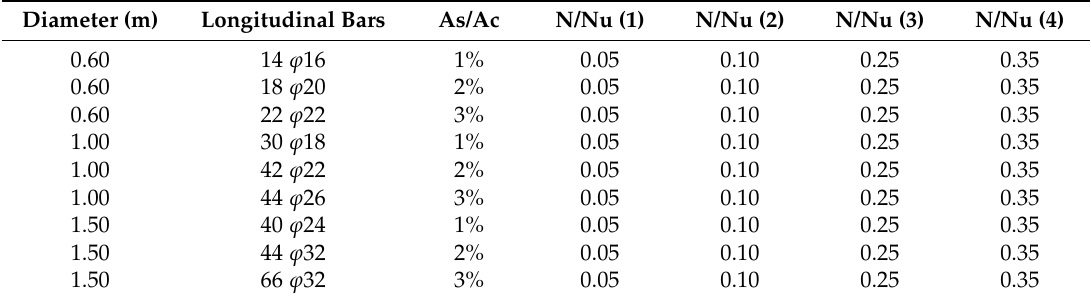
Table 4. Circular reinforced concrete sections used for the parametric study.